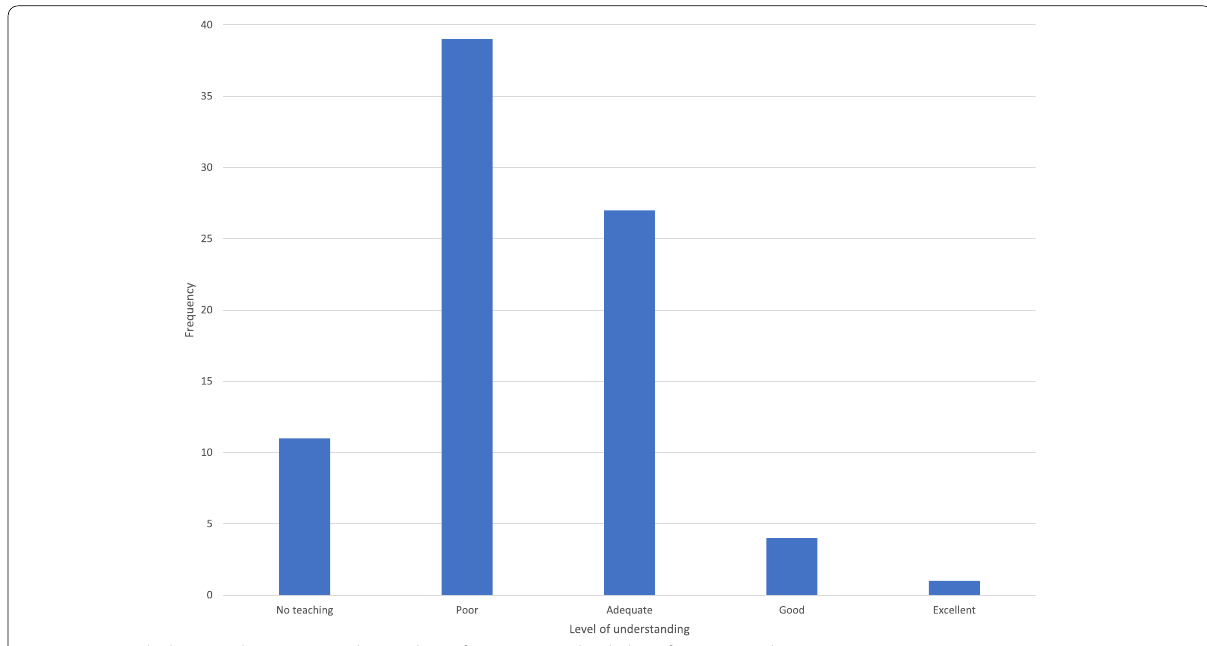
Fig. 1 Bar graph showing the current understanding of interventional radiology from respondents